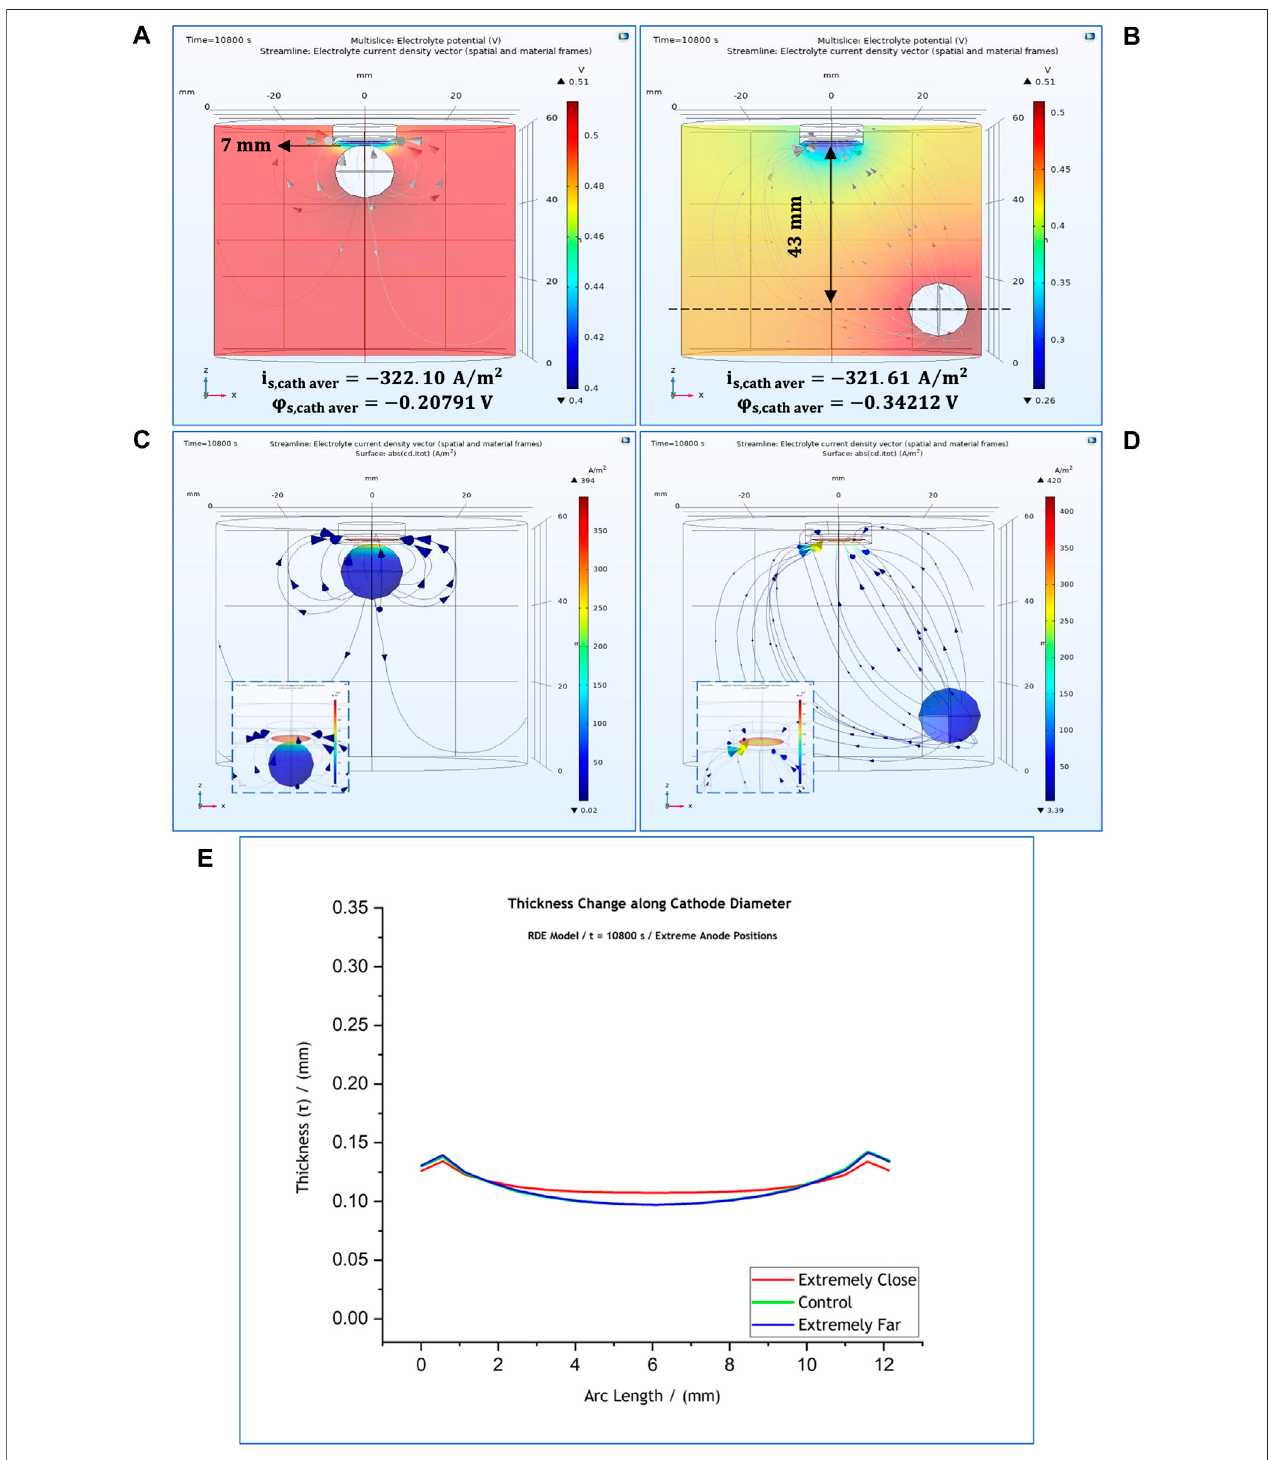
FIGURE 9 | 3-D representation of the potential distribution in the electrolyte volume of the RDE model when the anode is placed at (A) 7 mm and (B) 43 mm from the cathode surface. 3-D representation of the current streamlines on the cathode surface of the RDE when the anode is placed at (C) 7 mm and (D) 43 mm from the cathode surface. (E) Thickness pro fi les predicted for the geometries shown in fi gures (A,B) . The results simulate potential and current distributions after 3 h at 50 ℃ . Anode distances are provided with reference to its geometric centre.